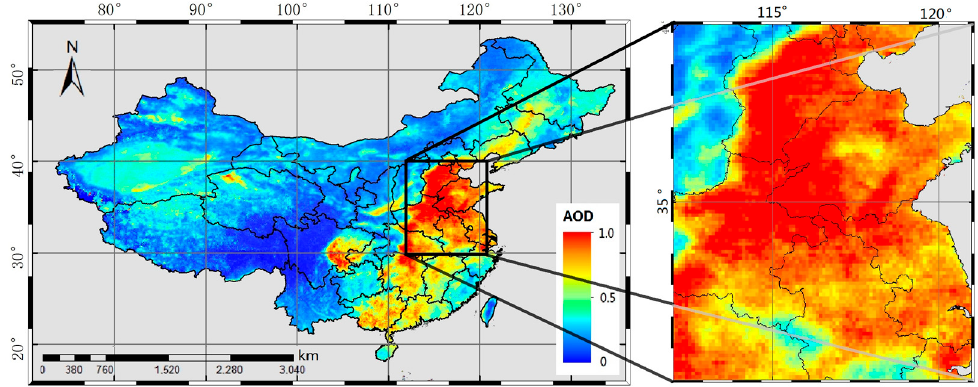
Figure 1. Annual average AOD distributions over the research area in 2015 (MODIS Collection 6 Deep Blue AOD at 550 nm). The right-hand figure shows the NCP, which is marked by a black square frame in the left-hand figure.